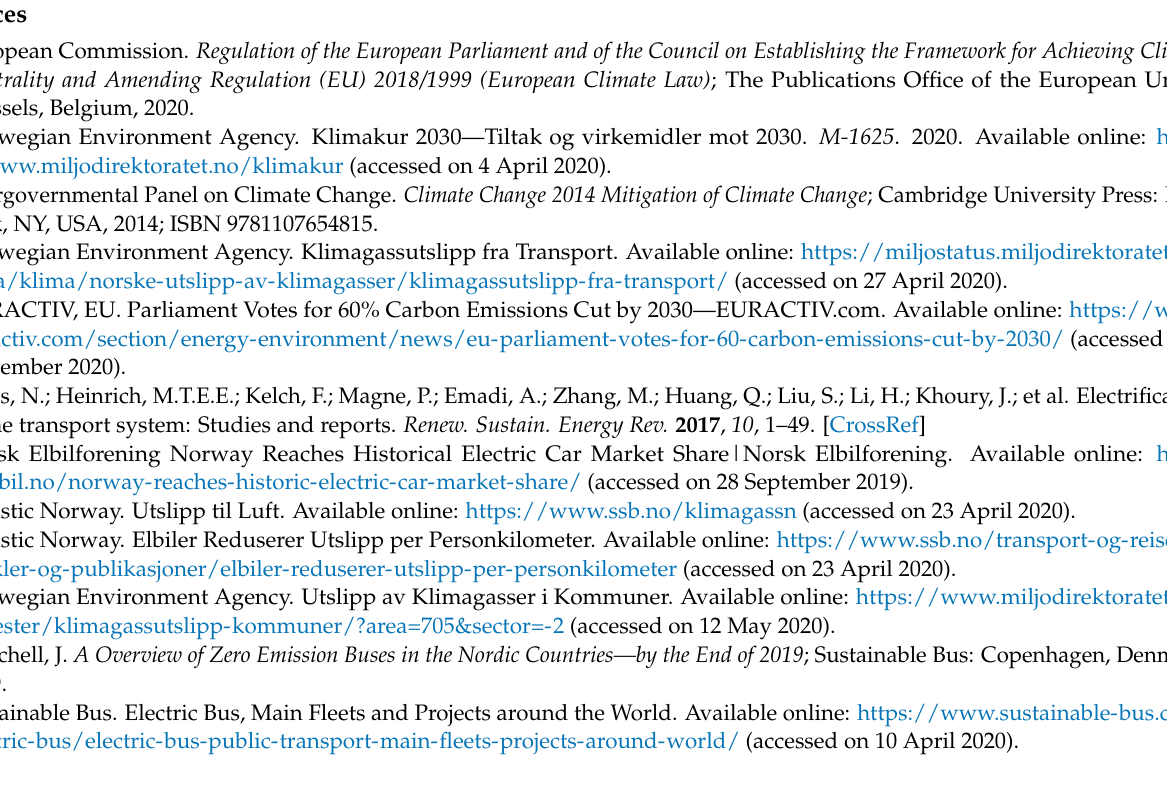
Norway). Table S11: Sensitivity analysis results for primary steel and aluminium production for three bus models with average, low and high emissions for the various bus models (unit tonnes CO 2 -eq). Table S12: Sensitivity analysis results for secondary steel and aluminium production for three bus models (unit tonne CO 2 -eq). Table S13: Sensitivity analysis for GHG emissions from dif-ferent battery capacities and carbon intensities. Table S14: Sensitivity on battery production car-bon intensity (CI) impact on bus fleet battery emissions (Unit g CO 2